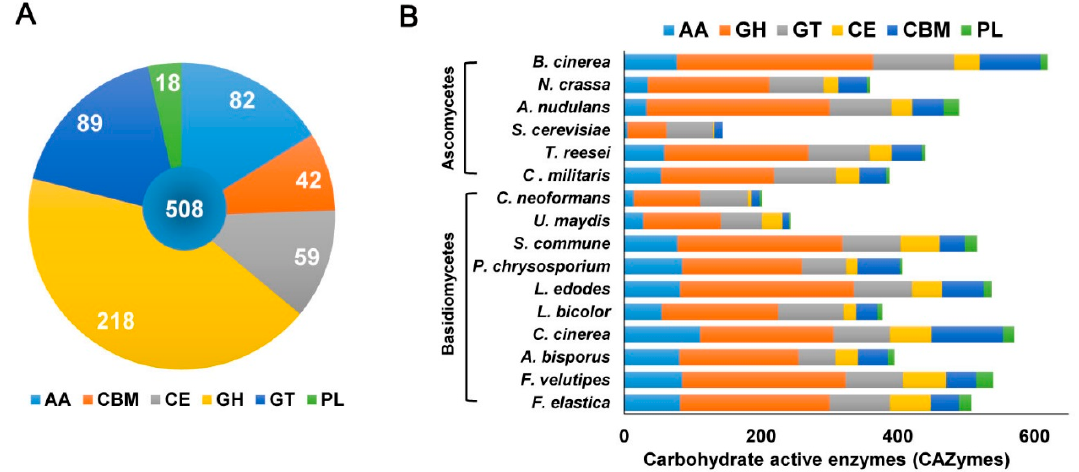
Figure 3. Carbohydrate-active enzymes in ( A ) the F. elastica genome and ( B ) other fungal species. AA, auxiliary activities; GH, glycoside hydrolase; GT, glycosyltransferase; CBM, carbohydrates- binding module; PL, polysaccharide lyase.